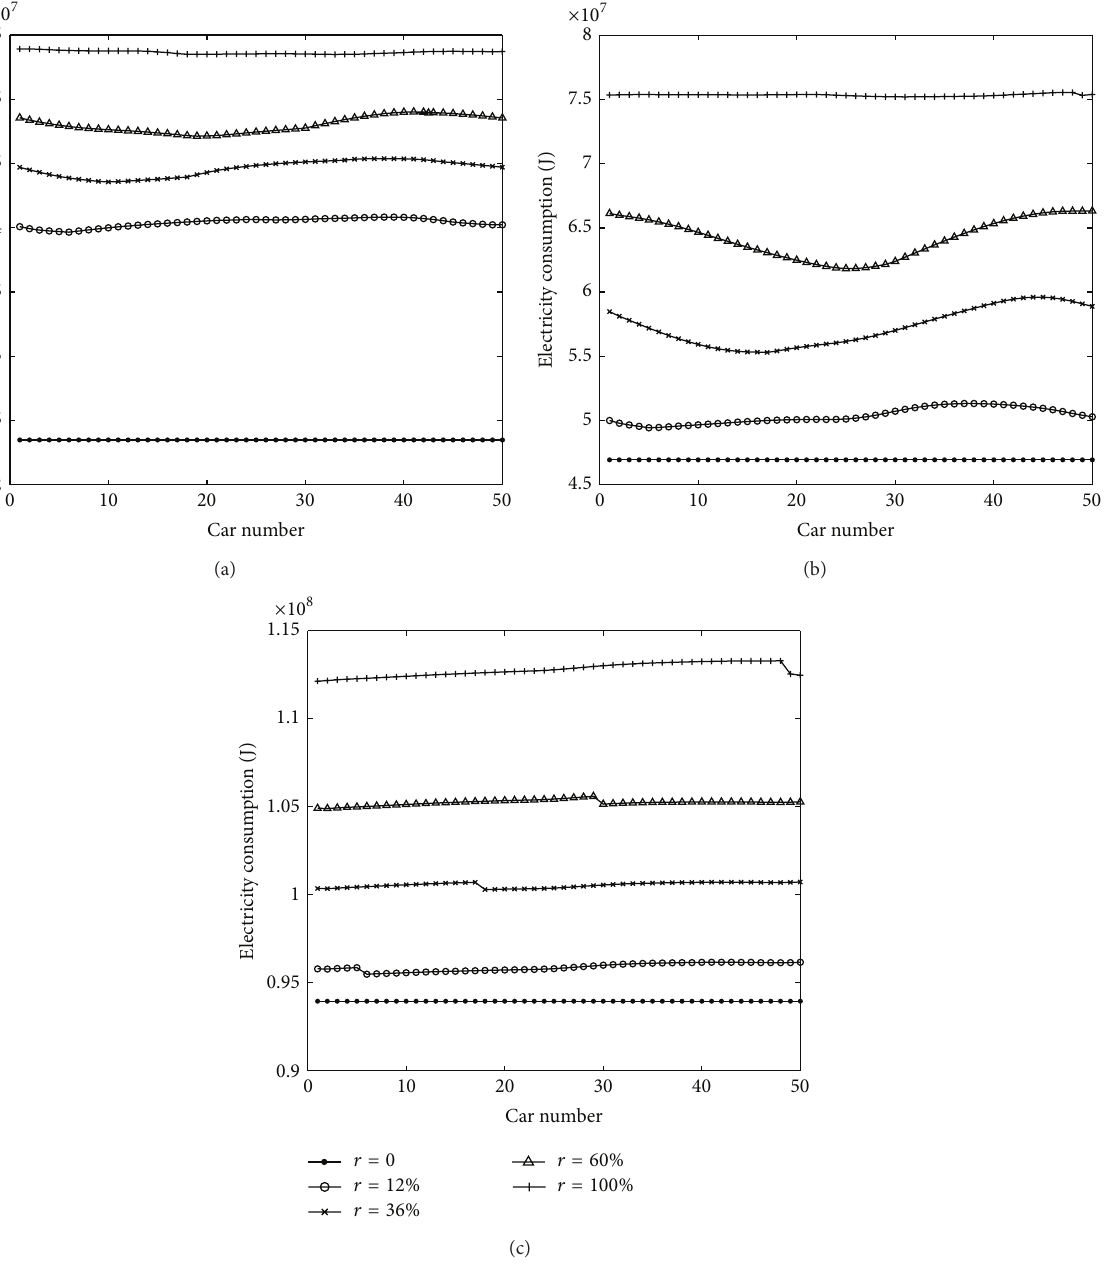
Figure 4: The total electricity consumed by each vehicle under 𝑇 0 = 240 s, where (a) Δ𝑥 0 = 20 m, (b) Δ𝑥 0 = 40 m, and (c) Δ𝑥 0 = 80 m.